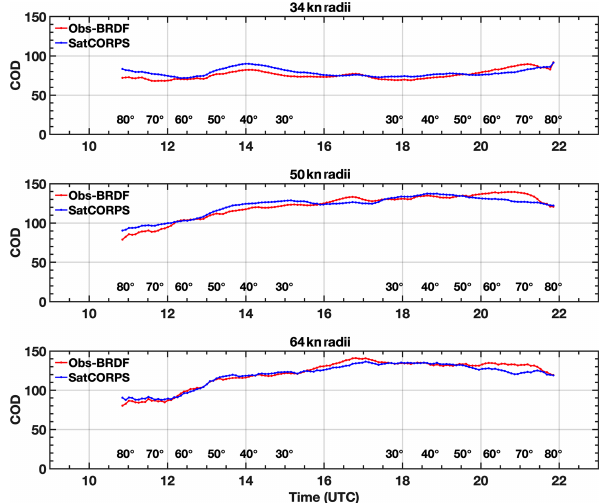
Figure 15. Cloud optical depth as a function of time (UTC hour) and SZA (listed in degrees) from SatCORPS (blue) and as de- termined from the SZA-dependent Obs − BRDF function (red) as shown in Fig. 9, derived over Hurricane Florence on 11 Septem- ber 2018 within the 34, 50, and 64kn radii as shown in Figs. 13 and